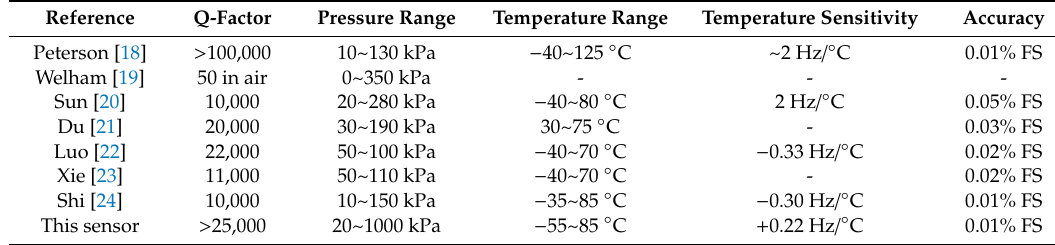
Figure 5. ( a ) Schematic of the closed-loop circuit. ( b ) The frequency responses as functions of the applied pressure in room temperature. ( c ) The frequency responses as functions of the surrounding temperature with the reference pressure of 100 kPa. ( d ) The fitting errors of the developed microsensor within the full pressure range of 20 kPa to 1 MPa and temperature range of − 55 to 85 ◦ C. ( e ) The measurement errors to the standard pressure of 20 kPa to 1 MPa under the surrounding temperature of − 55, 25, and 85 ◦ C. ( f ) The comparisons of the developed microsensor and the PACE5000 pressure calibrator in actual atmospheric pressure measurement. Table 1. Comparisons of microsensor performances.